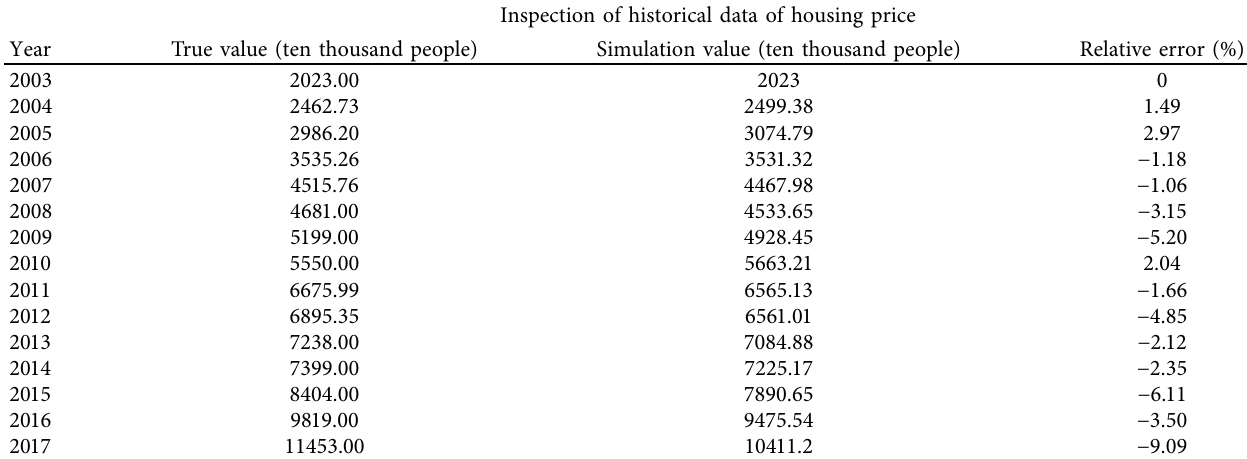
Table 11: Comparison between simulation and actual data.